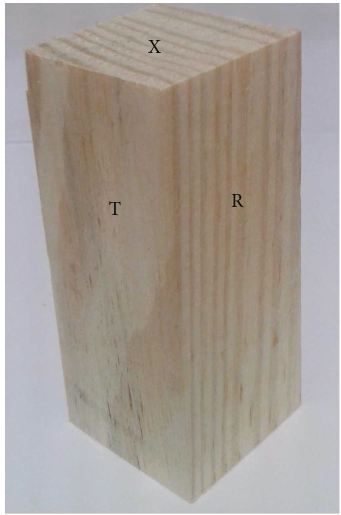
Figure 1: The three surfaces (radial, R; tangential, T; and transverse (cross-section), X) of a straight grained short, clear sample available for near-infrared (NIR) analysis. Note the arrangement of the growth